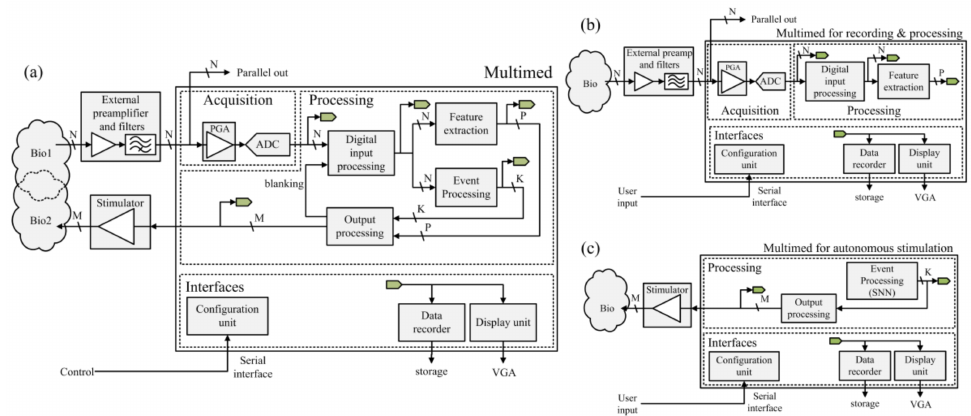
Figure 3. ( a ) Architectural description of the Multimed board and its peripherals. Data acquisition and processing is simultaneous on N channels. P features may be extracted from individual channels or as a synthesis of a cluster of channels. Features and events are processed to control stimulation on M configurable channels (trigger/configuration, electrical, or chemical). Stimulation-synchronized